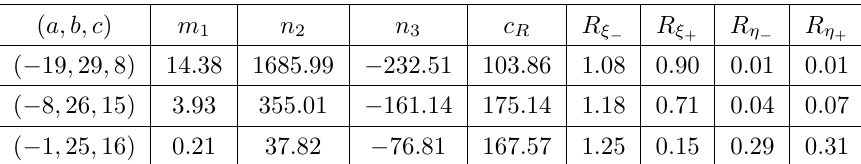
= c sugra (divided by ( g (cid:0) 1) N 2 ) and the R